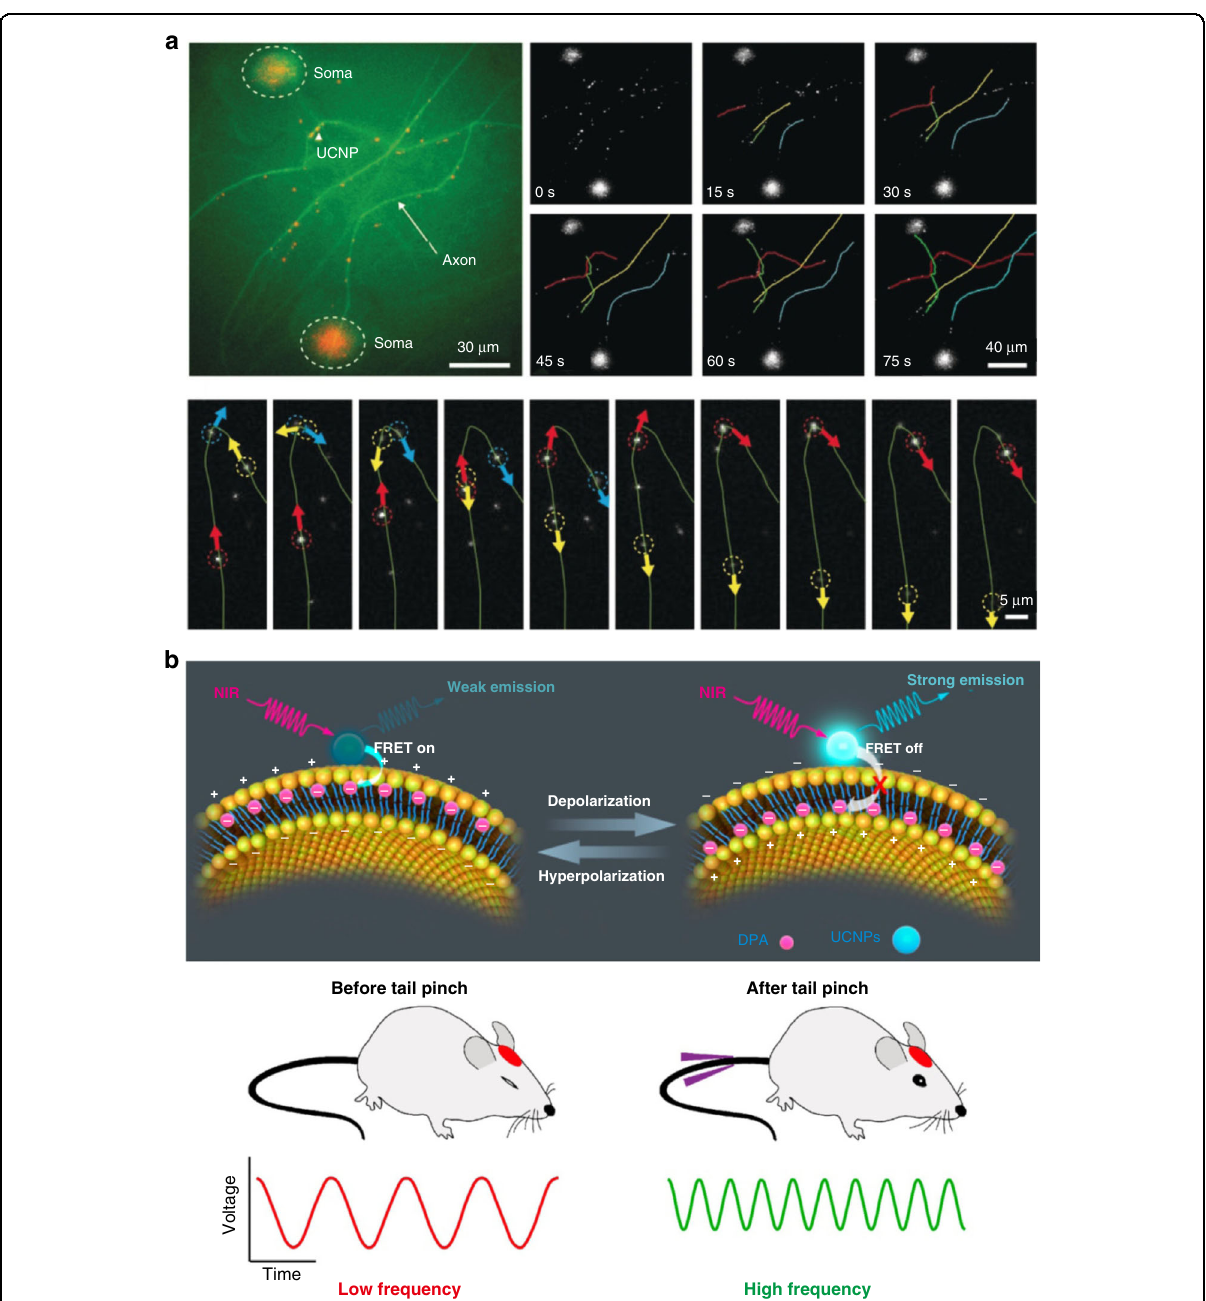
Fig. 7 Rare-earth based materials for monitoring the neural activity. a UCNPs-mediated visualization of retrograde axonal transport. Reprinted with permission from ref. 22 . Copyright 2019 Wiley-VCH GmbH. b The schematic diagram of the NIR-excited optical voltage sensor to real-time monitor the subthreshold activities in mouse cortical neurons. Reprinted with permission from ref. 93 . Copyright 2020 American Chemical